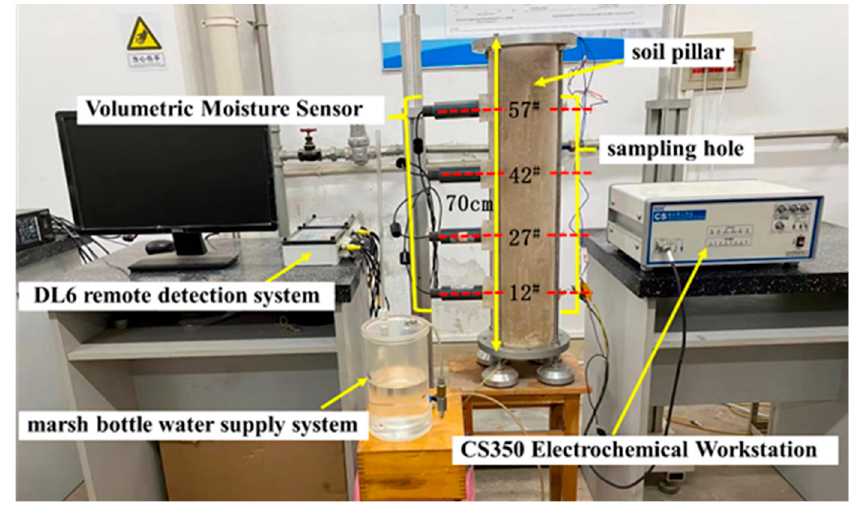
Figure 4. Geo-experts one-dimensional soil column instrument. .